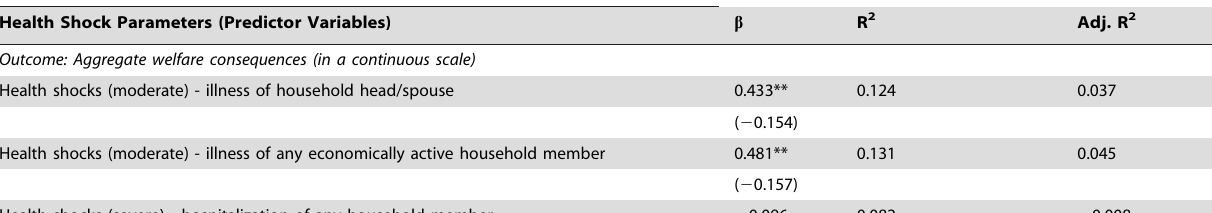
Panel A OLS Regression Model for Aggregate Welfare Consequences of Health Shocks Health Shock Parameters (Predictor Variables)